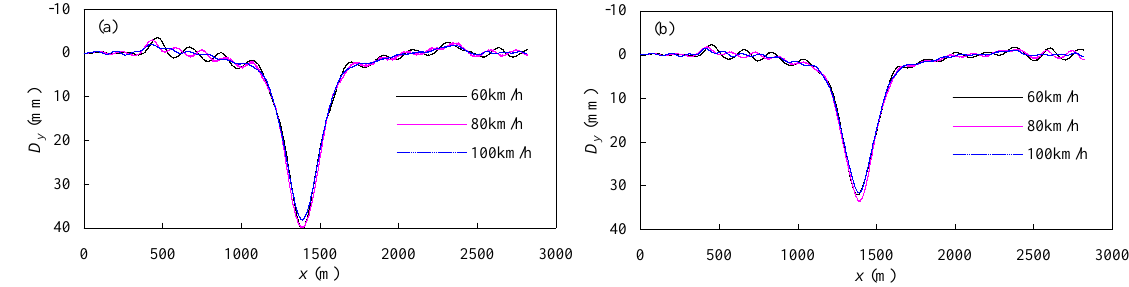
Figure 21. ( a ) Deflection response of CFRP cable-stayed bridge; ( b ) deflection response of steel-cable-stayed